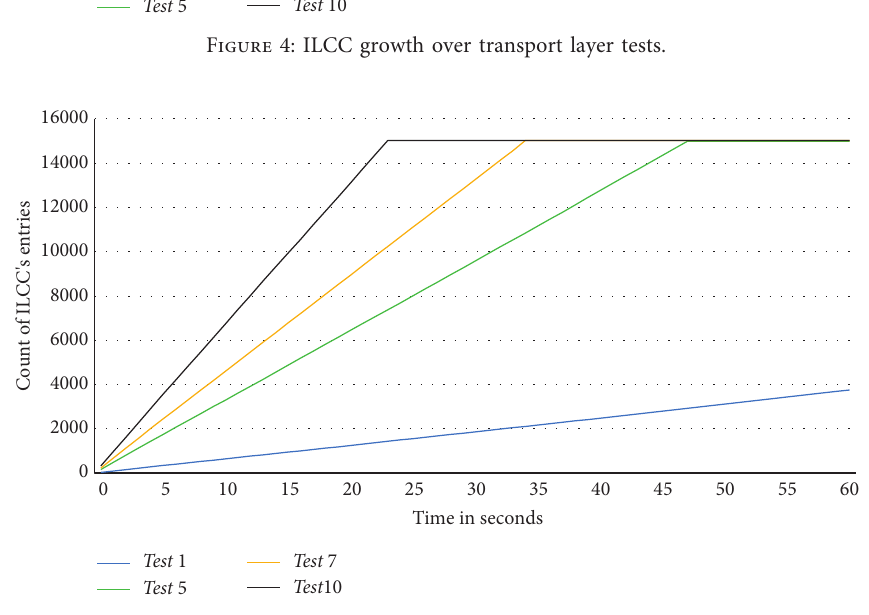
Figure 5: ILCC growth over network layer tests.